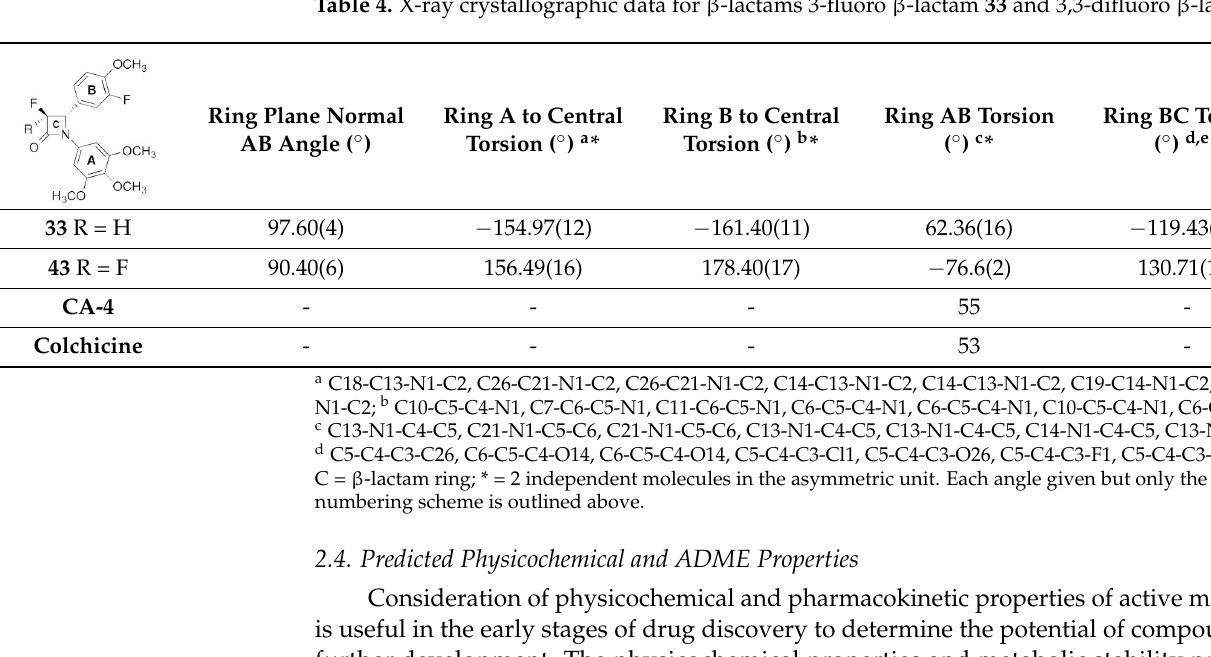
Table 4. X-ray crystallographic data for β -lactams 3-fluoro β -lactam 33 and 3,3-difluoro β -lactam 43 .